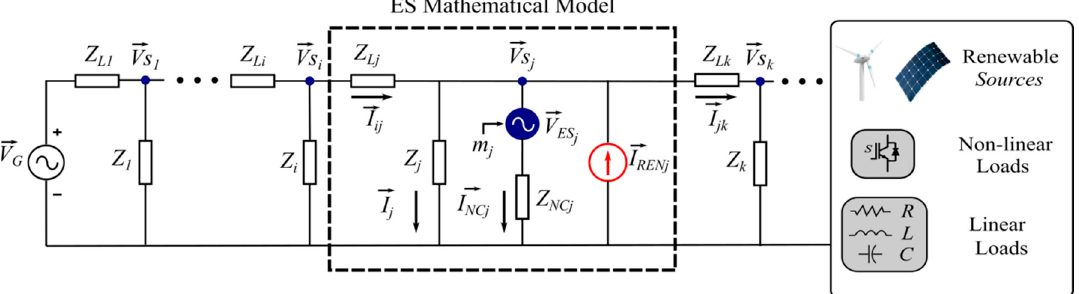
Figure 4. Circuit for the steady-state ES mathematical model.